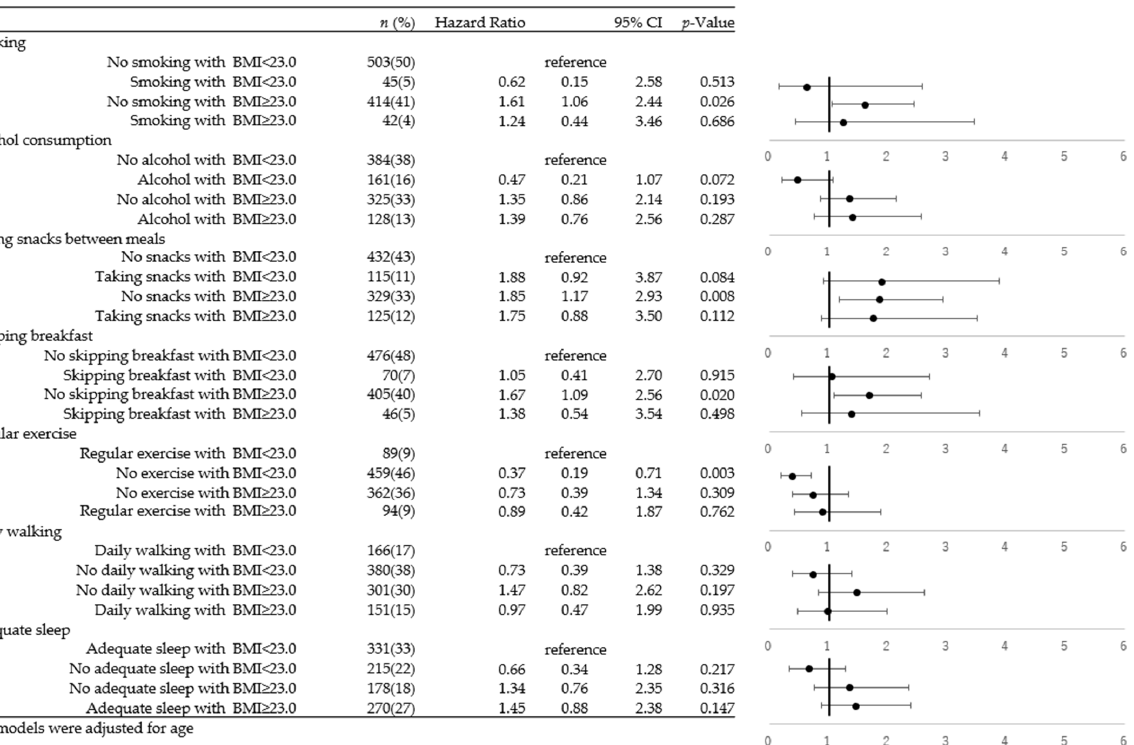
Figure 2. Cox proportional hazard model of the combination of BMI and lifestyles and the progression of kidney damage among males.